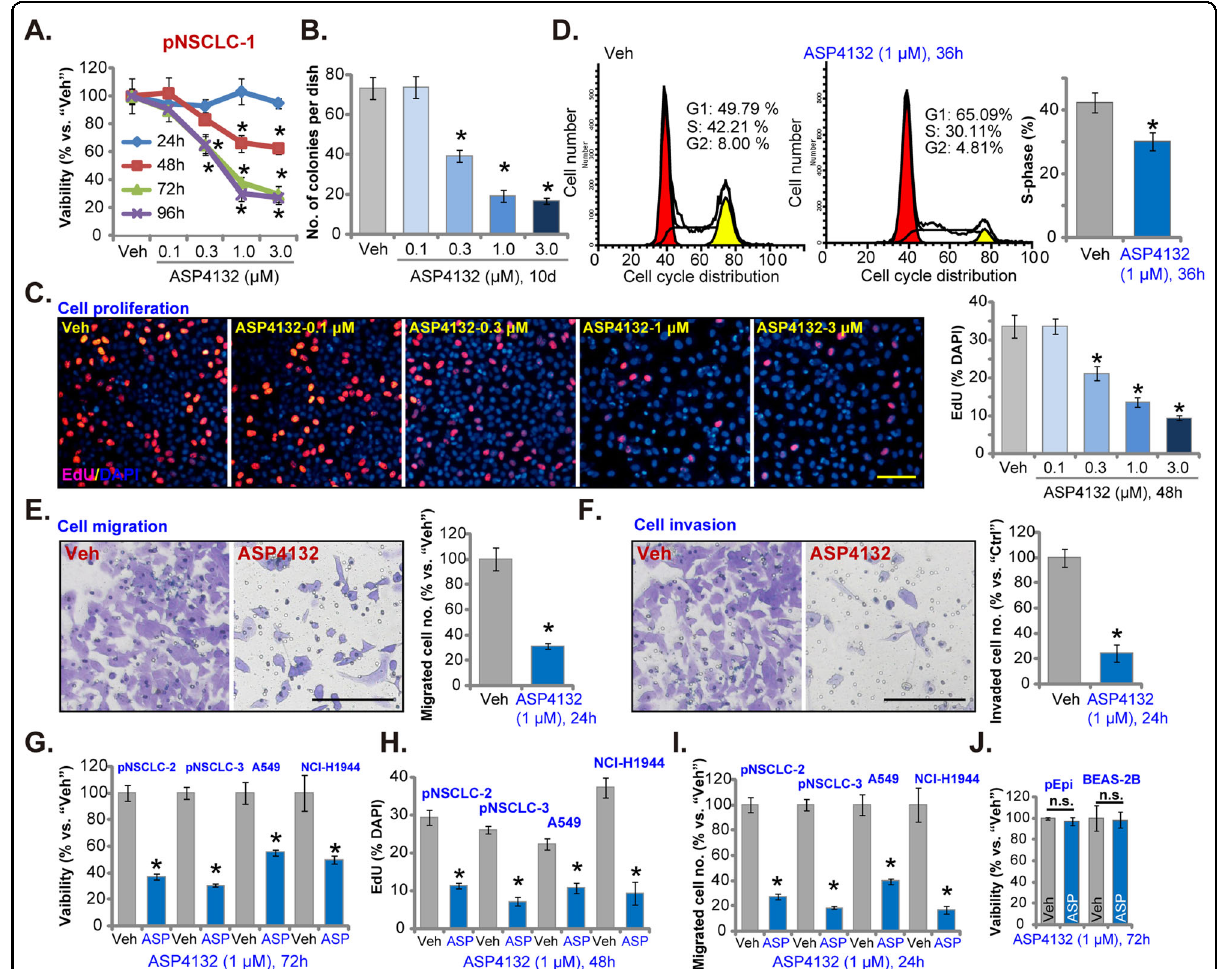
Fig. 1 ASP4132 treatment exerts potent anti-NSCLC cell activity. Primary NSCLC cells that were derived from different patients (pNSCLC-1/-2/-3), the immortalized NSCLC cell lines (A549 and NCI-H1944), as well as primary ( “ pEpi ” ) and established (BEAS-2B) lung epithelial cells, were treated with ASP4132 at applied concentrations, cells were further cultured for applied time periods, cell viability (CCK-8 assay, A , G , J ), colony formation ( B ), proliferation (EdU incorporation assay, C , H ), cell cycle progression ( D ), as well as cell migration ( E , I ) and invasion ( F ) were tested by assays mentioned in the text, with results quanti fi ed. For all EdU assays in this study, fi ve random views containing at least 1, 200 cells of each condition were included to calculate EdU ratio (% vs. DAPI). For all “ Transwell ” and “ Matrigel Transwell ” assays in this study, fi ve random views of each condition were included to calculate the average number of migrated/invaded cells. “ Veh ” stands for the vehicle control (Saline). Data were presented as mean ± standard deviation (SD, n = 5). * p < 0.05 vs. “ Veh ” cells. “ n.s. ” stands for no statistical difference ( J ). The experiments were repeated fi ve times with similar results detected. Scale bar = 100 μ m ( C , E , F